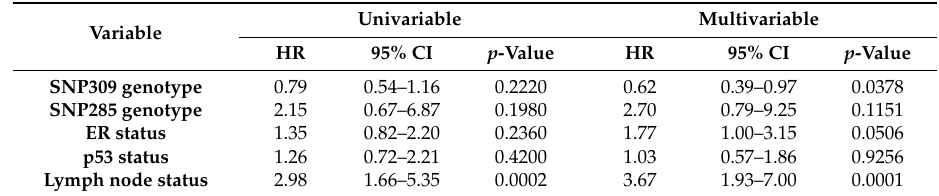
Table 6. Univariable and multivariable analyses of the metastasis-free survival using a Cox proportional hazards